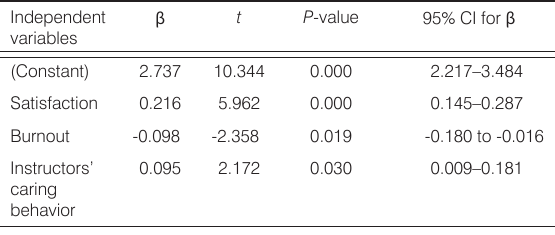
Table 3. Correlation between major